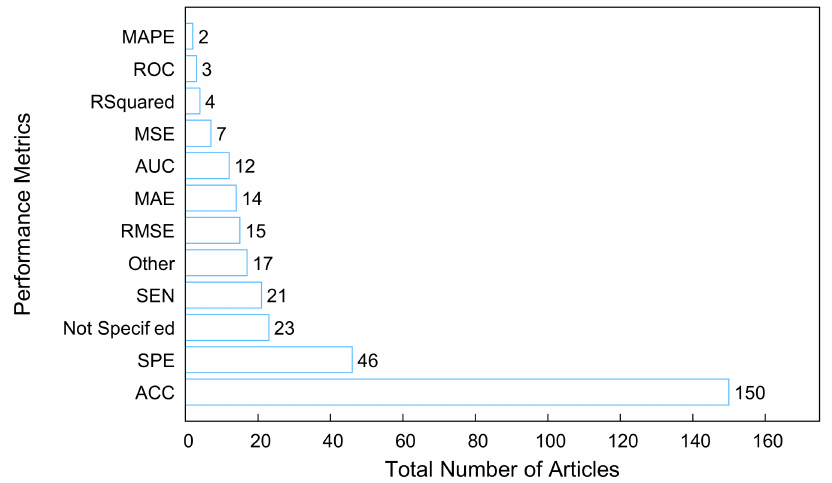
Figure 13. Performance Metrics provided by the